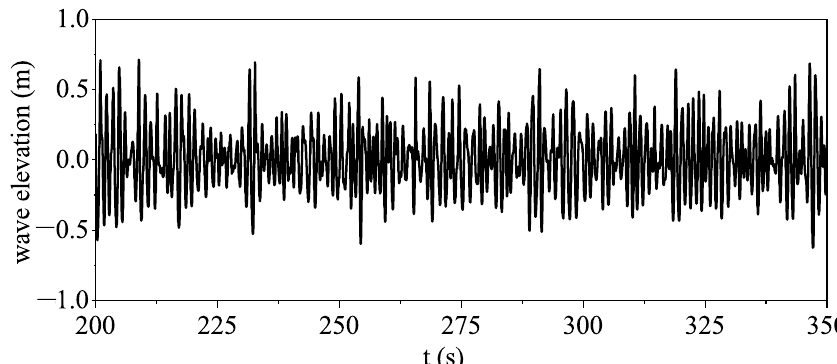
Figure 9. The time history of the wave elevation for the used JONSWAP spectrum.